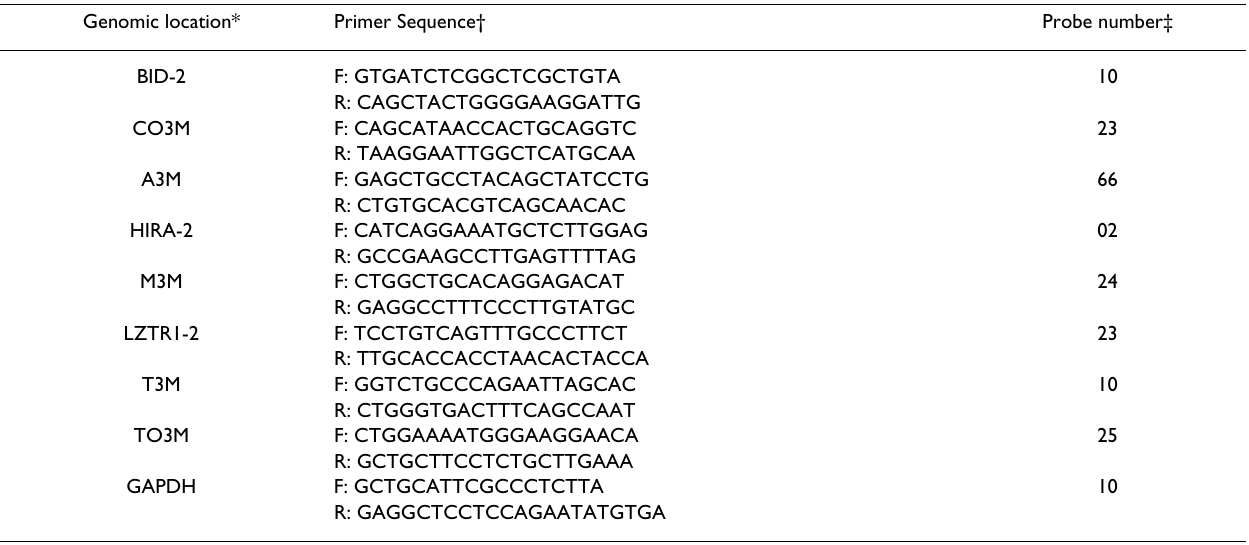
Table 2: A list of primer and TaqMan probe for quantitative real-time PCR Genomic location*